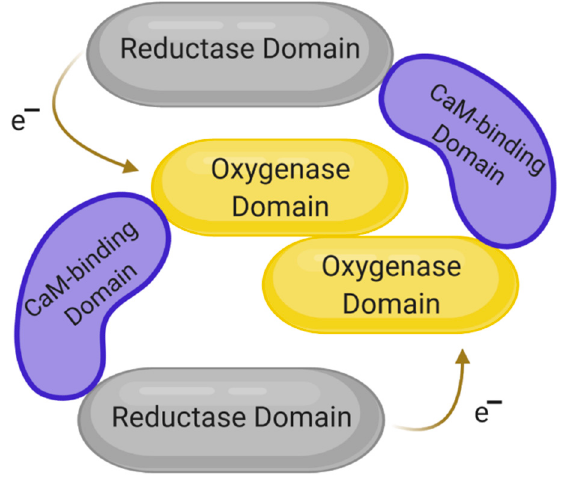
Figure 1. Schematic structure of nitric oxide synthase (NOS). Modified based on [49,50]. Created with BioRender.com. Legend: CaM—calmodulin; e − —free electron.